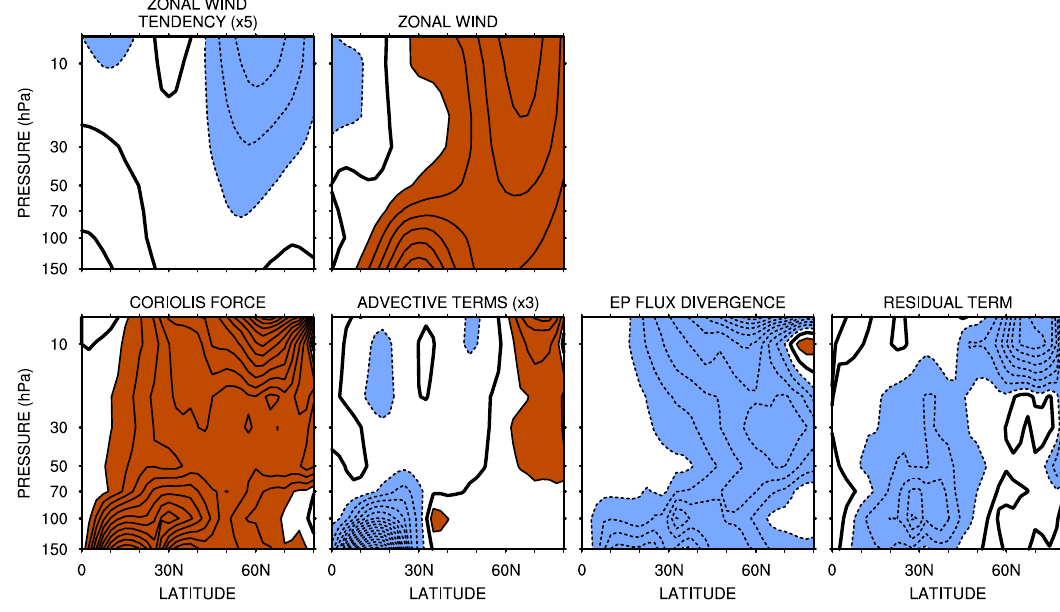
Fig. 2. Latitude-height cross-sections of the zonal-mean zonal wind, zonal wind tendency and its forcing terms in the Northern Hemisphere averaged over JFM 1980–2001 for the ERA-40 reanalysis. Dashed (solid) lines and blue (brown) shadings represent negative (positive) values while the bold solid line represent the zero-line. Contour interval is 6ms − 1 for the zonal wind and 0.5ms − 1 day − 1 for the zonal wind tendency and forcing terms. Note that the zonal wind tendency and advective terms are weak compared to the other terms and are therefore multiplied by 5 and 3